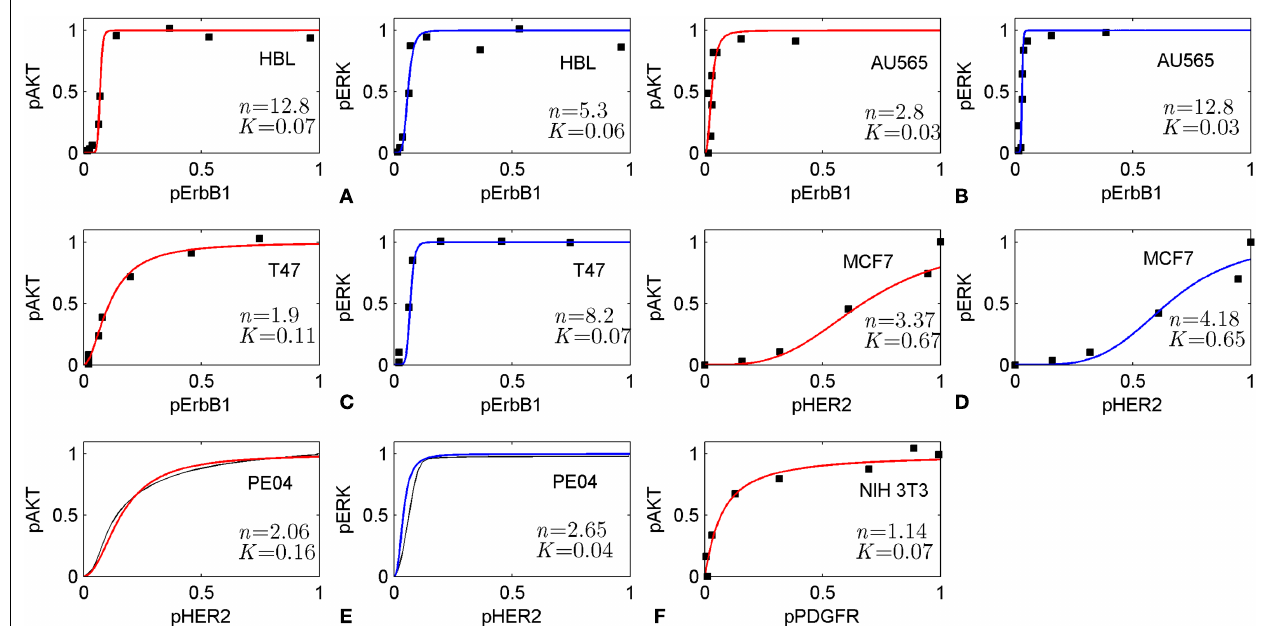
normalized at maximal values of input/output signals. p AKT, p ERK dose dependencies for PE04 cells (E) are theoretical data (40) (black lines). Experimental data were fitted by Hill function: y = x n /(x n + K n ) with Hill constant, n , and half-maximum constant, K , which are given in Figures. Hill function is depicted by red lines for p AKT and blue lines for p ERK. Experimental data were kindly allowed to be used by PK Sorger (A–C) , M Hatakeyama (D) , and JM Haugh (E)